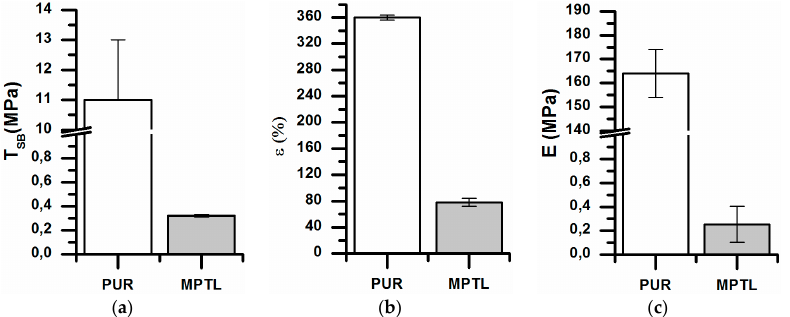
Figure 4. Mechanical properties of native PUR and fabricated MPTL scaffold: ( a ) tensile strength (T Sb ); ( b ) elongation at break ( ε ); and ( c ) Young’s Modulus (E).